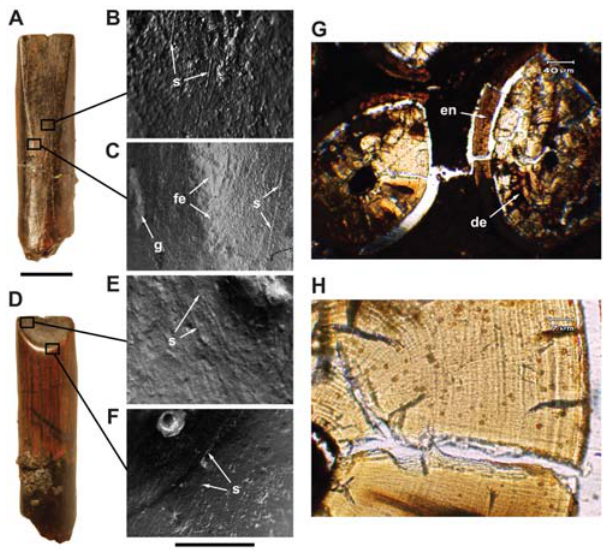
Figure 2. Crown form, wear pattern, and microstructure in Nigersaurustaqueti. Wear facets and surface detail is from a worn crown (MNN GAD513), and enamel and dentine microstructure is from left premaxillary teeth in cross-section (MNN GAD514). (A)-Crown in lingual (interior) view showing low-angle wear facet. Magnified views of a cast of the lingual wear facet showing (B)-wear striations in the dentine and (C)-the edge of the facet. (D)-Crown in labial (exterior) view showing high-angle wear facet. Magnified views of a cast of the labial facet showing (E)-coarse scratches on the dentine and (F)-fine scratches on the edge of the facet. (G)-Transverse thin section of two successive premaxillary crowns showing thickened labial enamel and circumfer- ential incremental lines of von Ebner in the dentine. (H)-Magnified view of the older (left) crown showing approximately 60 incremental lines of von Ebner. Scale bar in A and D equals 5 mm; scale bar below F equals 0.5 mm in B, E and F and 1.11 mm in C. Abbreviations : de , dentine; en , enamel; fe , facet edge; g , gouge; s ,